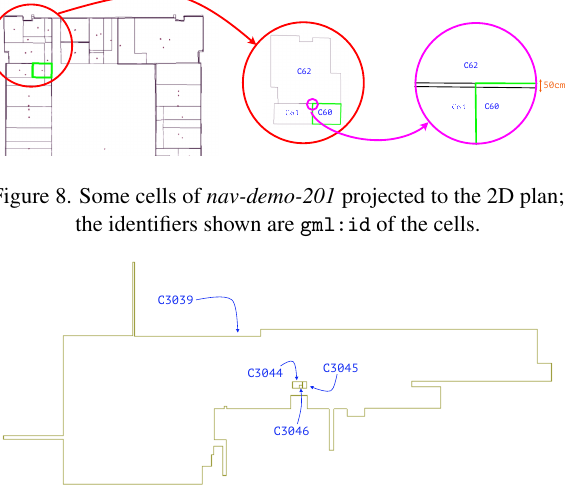
Figure 9. Top-view of 4 cells in LWM on the same floor: cell C3039 overlap with C3044 , C3045 , and C3046 . There are 398 pairs of cells overlapping for this